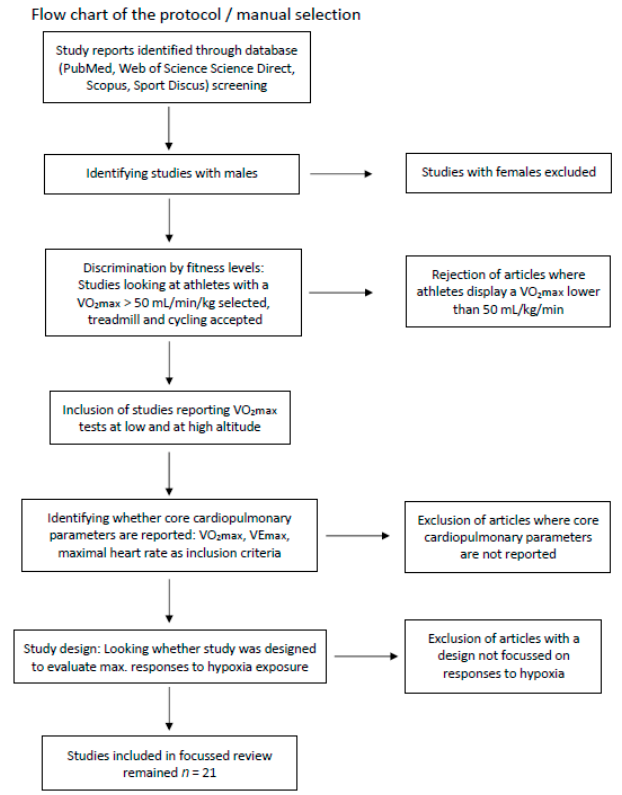
Figure 1. Flow chart of the protocol.